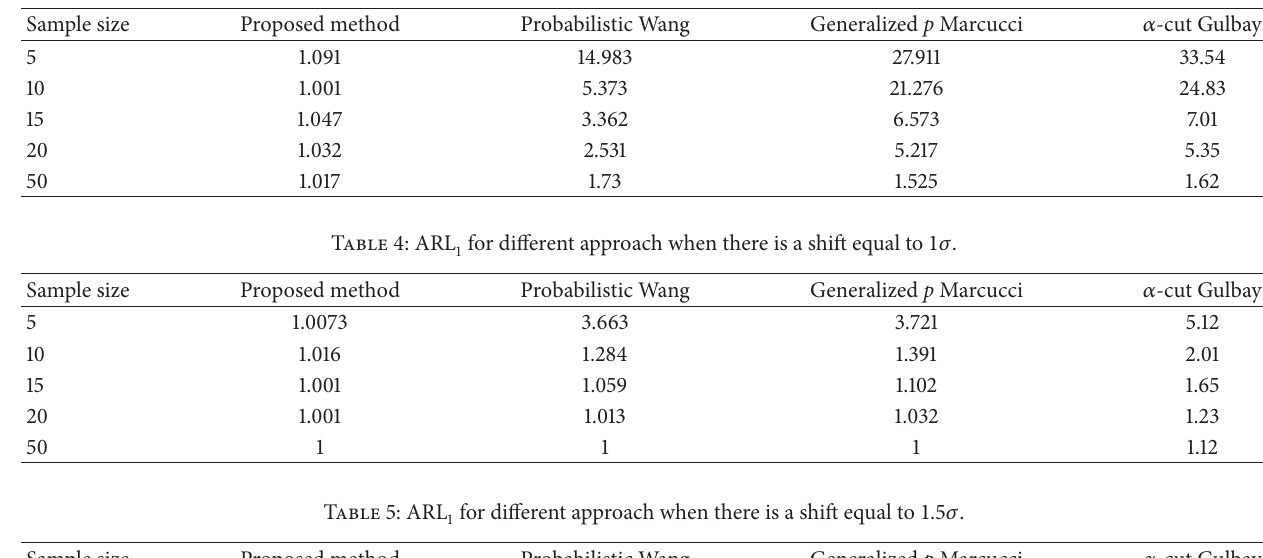
Table 3: ARL for different approach when there is a shift equal to 0.5𝜎 . 1